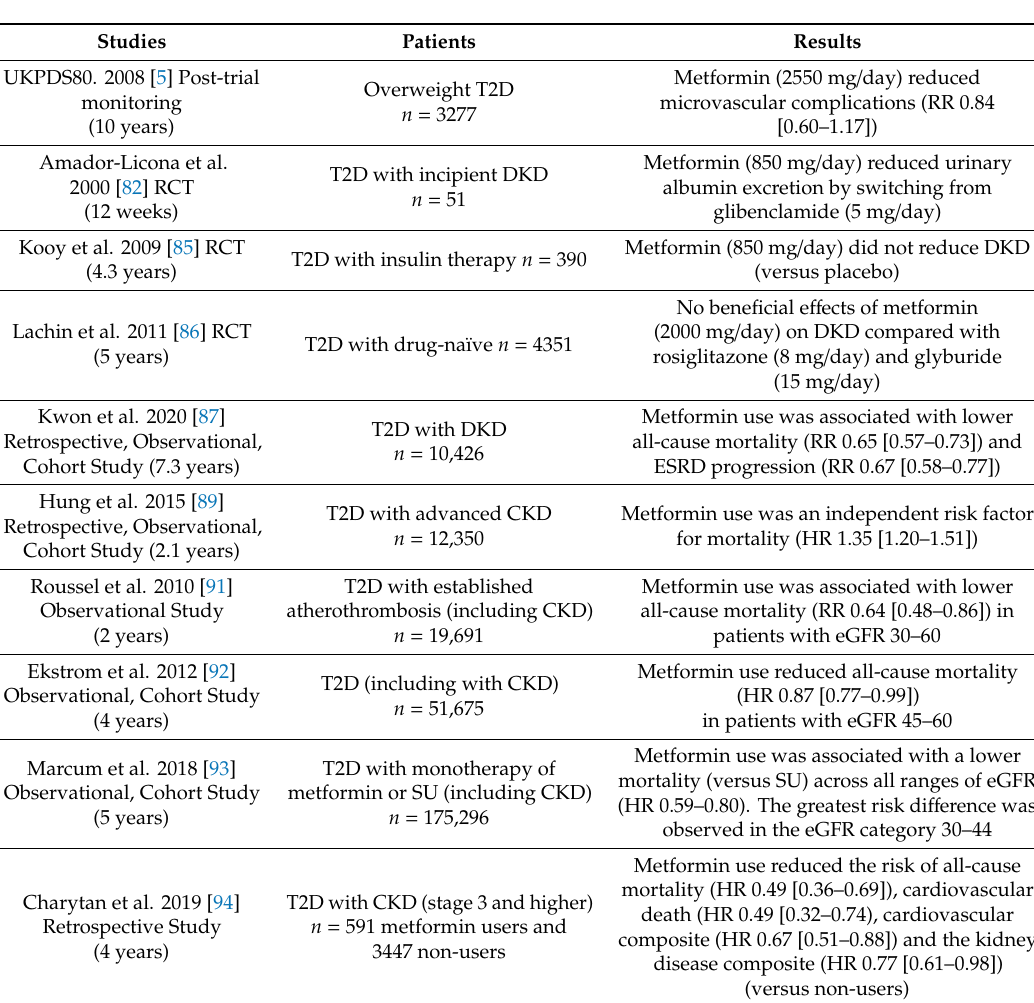
Table 2. Clinical e ff ects of metformin on DKD. Metformin use is associated with reduced mortality in T2D with CKD. However, metformin increases the mortality risk in patients with advanced CKD. The dose of metformin is indicated when such data were available. UKPDS: United Kingdom Prospective Diabetes Study, T2D: type 2 diabetes, RR: relative risk, RCT: randomized controlled trial, DKD: diabetic kidney disease, ESRD: end stage renal disease, CKD: chronic kidney disease, HR: hazard